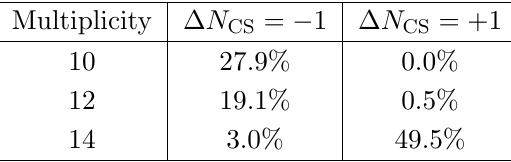
Table 1 . The fractions of each fermion multiplicity of sphaleron-like transitions, with and equal probabilities for (cid:1) N CS = (cid:0) 1 and (cid:1) N CS = +1, from a generated sample of 10 7 events and CT10 PDFs.